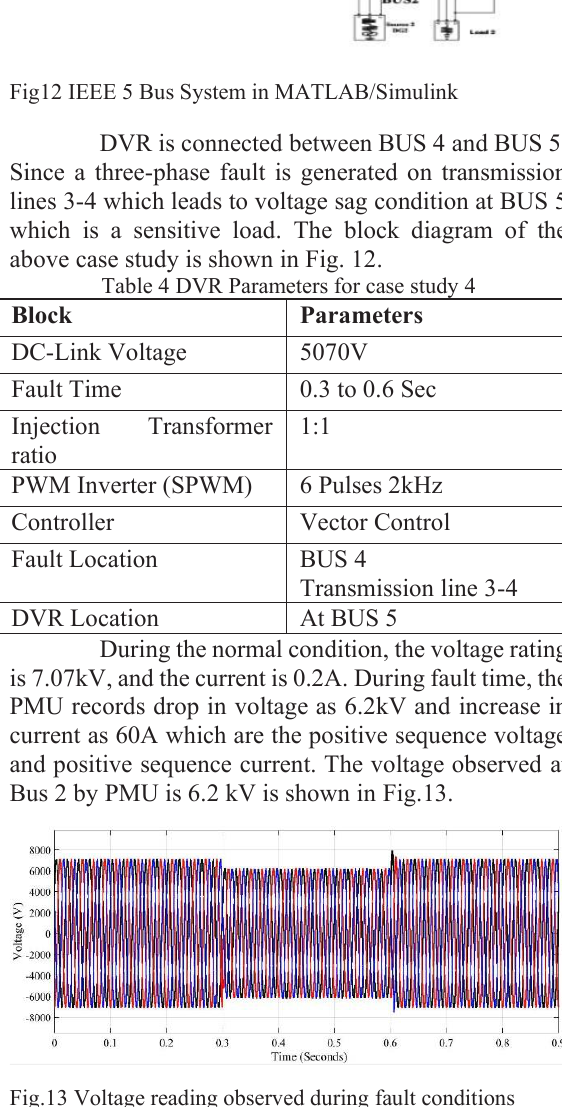
Fig.13 Voltage reading observed during fault conditions The expanded waveform of voltage rating is shown in Fig 14.